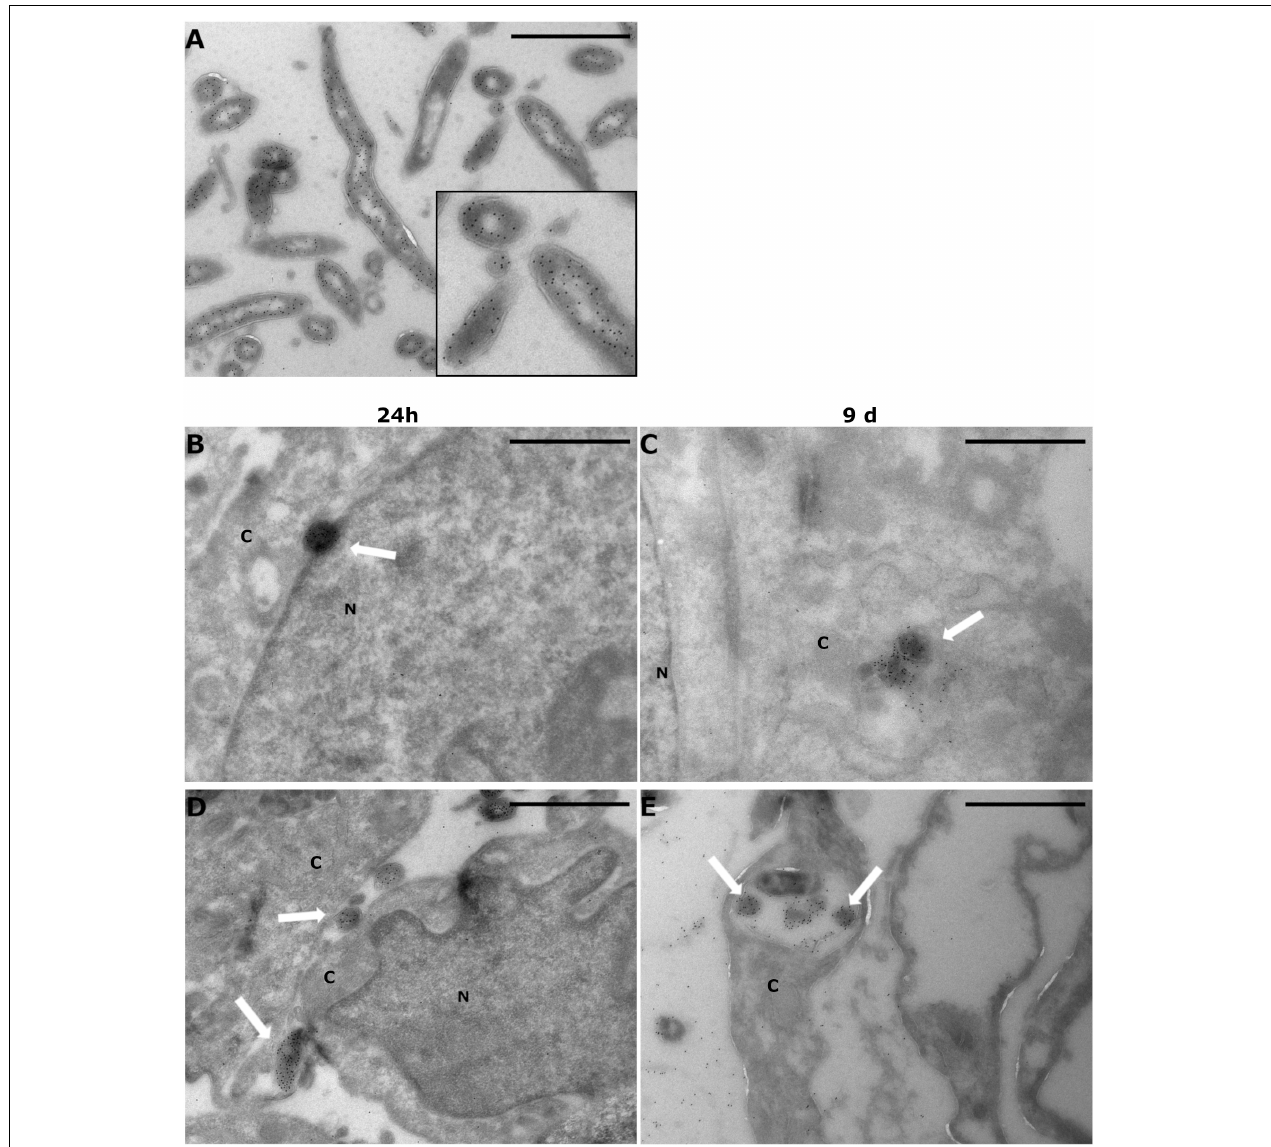
FIGURE 5 | Borrelia burgdorferi was found inside human cells even after 9 days post-infection. SW1353 and BJ cells were infected with Borrelia GCB726 strain with GFP for 24 h and 9 days. Infected cells were prepared for cryo-electron microscopy with GFP immunolabeling using anti-GFP antibody and Protein A-gold particles (diameter 10 nm). Transmission electron microscopy (JEOL JEM1400) was utilized in visualizing the samples. (A) Borrelia control with a zoomed image (black box), (B,C) SW1353 samples at 24 h and 9 days, respectively, and at the bottom the infected BJ cells (D,E) . White arrows indicate Borrelia in the infected samples. Cytoplasm (C) and nucleus (N) of the cells are indicated. Scale bars 1 µ